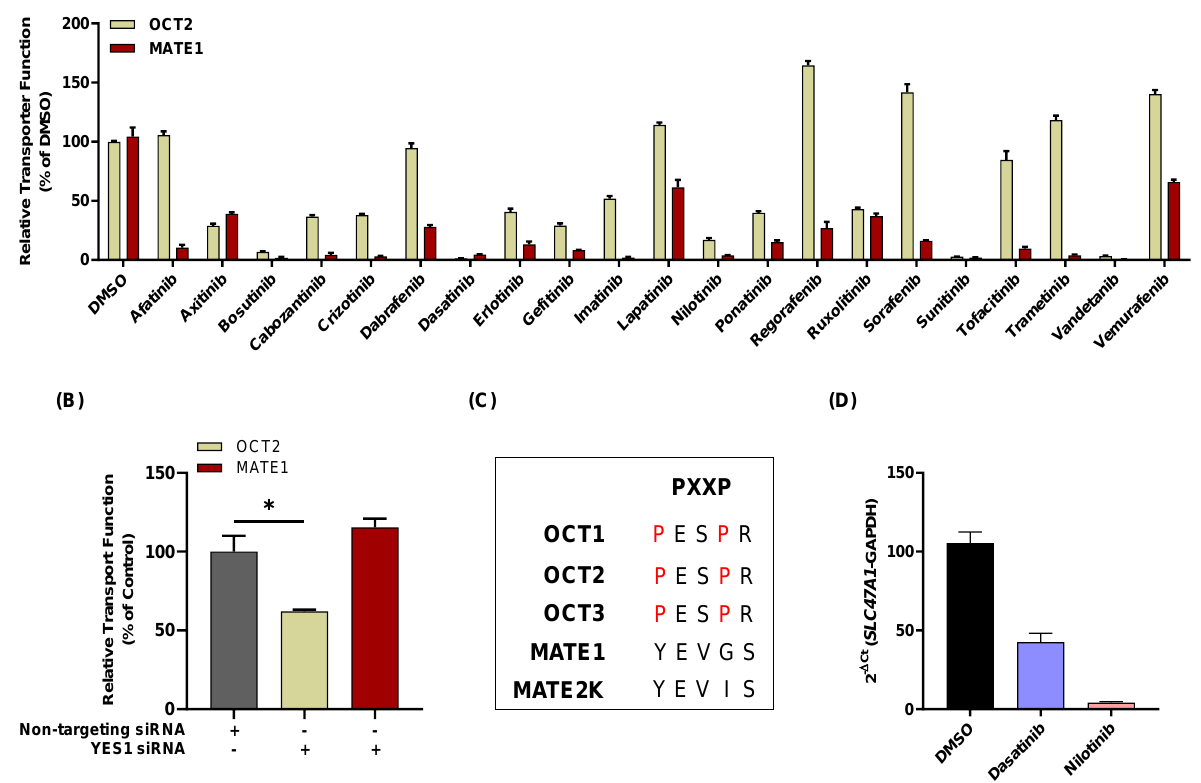
Figure 3. Influence of TKIs on MATE1 expression. ( A ) Relative transporter function in HEK293 cells stably transfected with human OCT2 and MATE1 [derived from Figure 1A] was evaluated by a substrate drug [ 14 C] TEA in the presence of FDA approved TKIs (10 µ M). The graph represents relative transport activity of indicated substrate drug compared to DMSO. ( B ) siRNA (25 nM)-mediated knockdown of YES1 kinase and its effects on HEK293 cells overexpressing human OCT2 and MATE1 using uptake assays with [ 14 C] TEA. The treatment condition for each bar is mentioned below the graph. Data are shown as mean ± SEM (* p < 0.05). ( C ) Protein sequence of OCT1, OCT2, OCT3, MATE1 (residue 277) and MATE2K was aligned by a multiple sequence alignment program (MAFFT). ( D ) Effect of select TKIs on the expression of MATE1 gene as measured by RT-PCR (results are reported as a difference with the repective control containing empty vector).